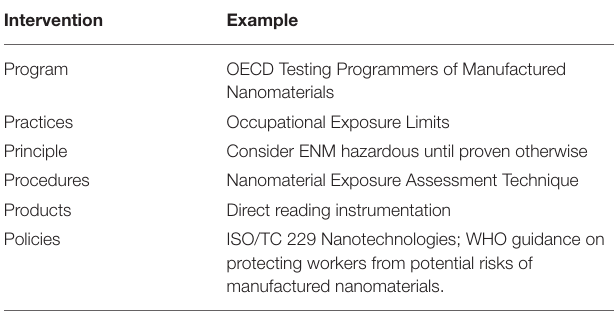
TABLE 2 | Examples of interventions to address worker exposure to